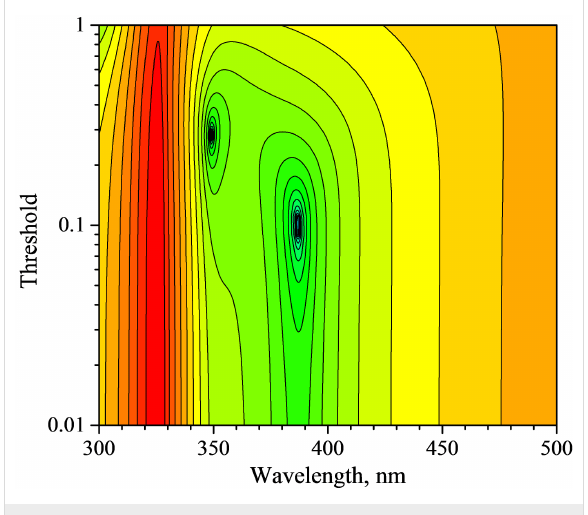
Figure 2: Relief of the function D 2 ( λ , γ ) for a nanotube with a = h = 30 nm, d = 10 nm, α =